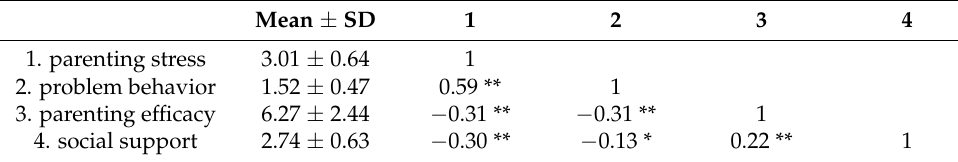
Table 2. Description and correlation of